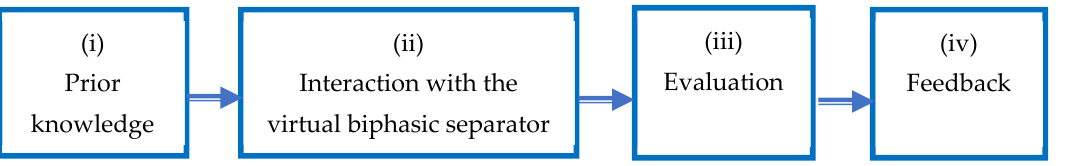
Figure 4. The procedure used in the teaching process.